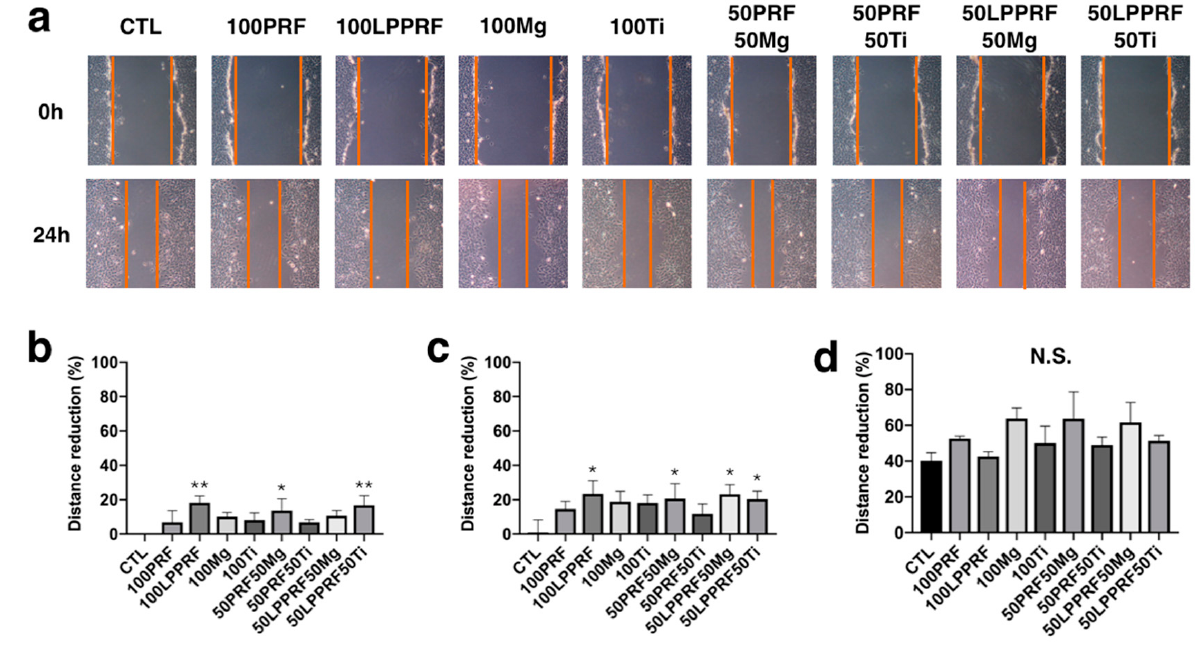
Figure 7. Migration capacity of MC3T3-E1 preosteoblasts cultured with platelet-rich fibrin, large-pore platelet-rich fibrin, magnesium ring and titanium ring precipitate media and their mixtures. ( a ) Cell migration at first scratch and after 24 h of incubation; reduction of the gap due to migration of MC3T3-E1 preosteoblasts after ( b ) 4, ( c ) 8 and ( d ) 24 h of incubation. (N = 5 per group; * p < 0.05 and ** p < 0.01) .